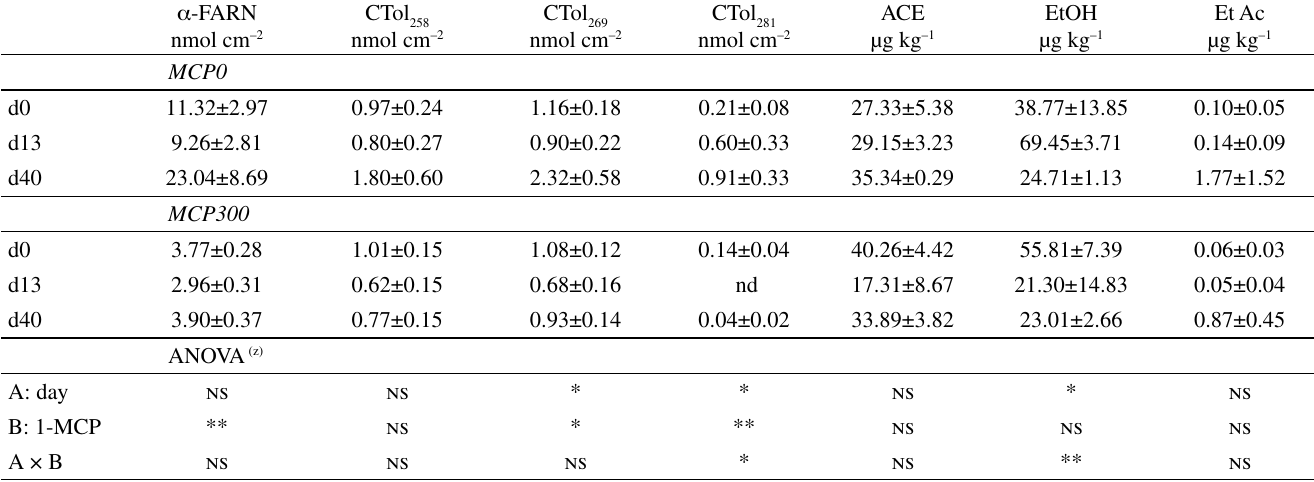
Table 1 - Amounts (mean ± standard error) of α -farnesene ( α -FARN), CTols (CTol dehyde; EtOH, ethanol; EtAc, ethyl acetate) in control (MCP0) and 1-MCP treated (MCP300) ‘Conference’ pears at the beginning (d0) and at the end (d13) of the second ILOS period and in correspondence with the first storage time (d40) and ANOVA results α -FARN